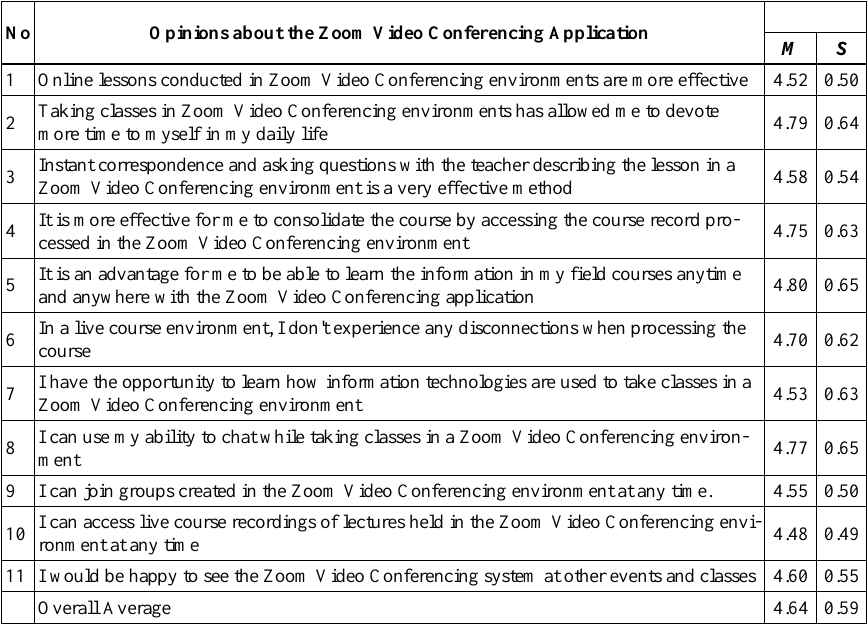
Table 6. Opinions of university students about the Zoom video conferencing application